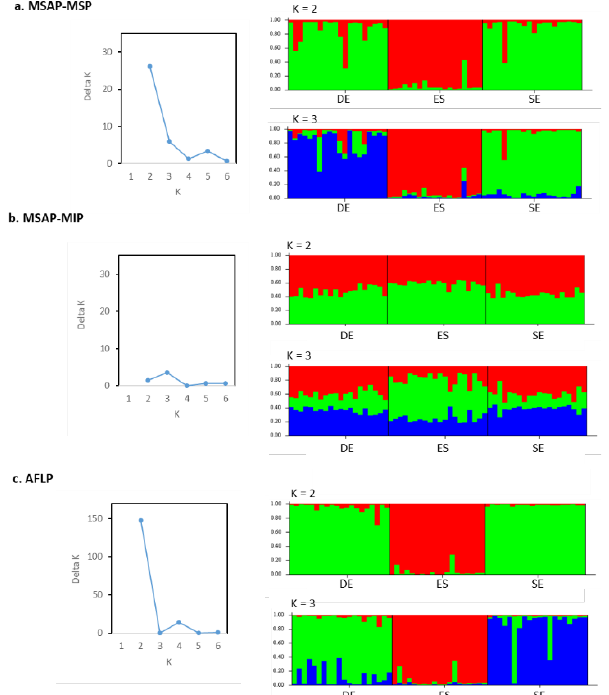
Figure 2. Plot of delta K values and the population structure diagram of the Spanish (ES), Swedish (SE) and German (DE) provenances using MSAP-MSP ( a ), MSAP-MIP ( b ), or AFLP ( c ).